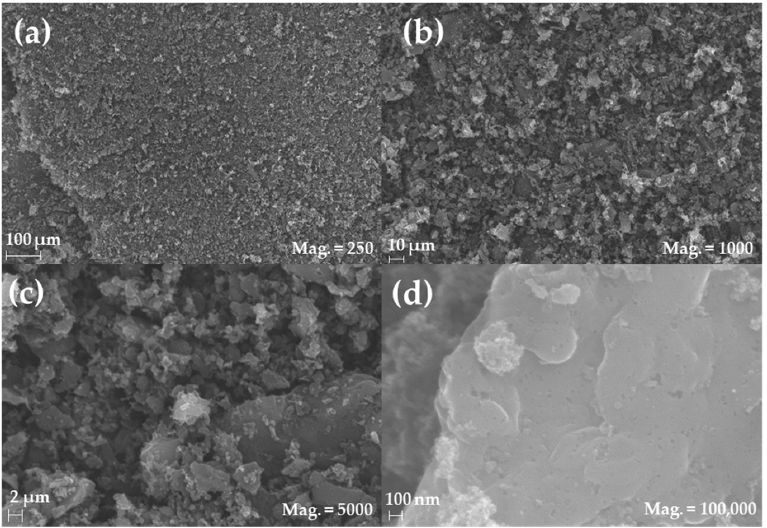
Figure 5. SEM images of the Rh/C catalyst, with magnifications from 250 to 10,000, ( a – d ). All images were taken with following parameters: EHT = 20.0 kV, WD = 8.5 mm, SingalA = InLens.